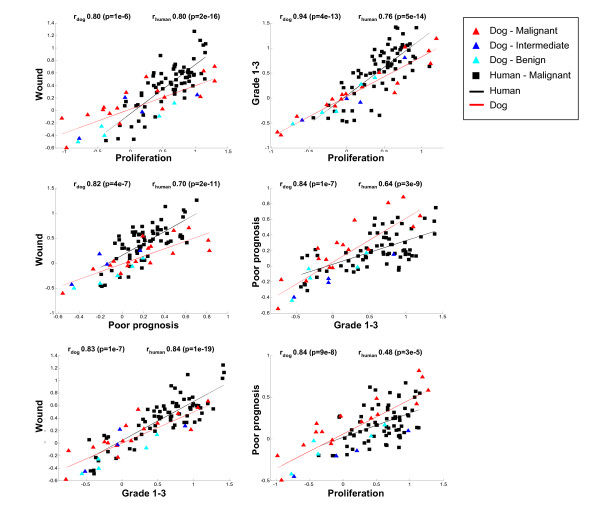
Relationships between prognostic signatures. Scatter plots showing the pair wise relationships between the prognostic signatures. For each signature the score was calculated as the weighted average of the expression level of the genes in the signature (see Methods). To compensate for the possibility that different signatures might show high correlation merely as a result of a common gene composition, the overlapping genes between each signature pair were not taken into account in the computation of the scores. Each point in the scatter plots represents a single tumor analyzed in the human and the dog dataset, respectively represented by squares and triangles. The Pearson's correlations and the corresponding p-values between each pair of expression signatures across the human (n = 68) and canine (n = 26) tumor datasets are indicated in each panel.